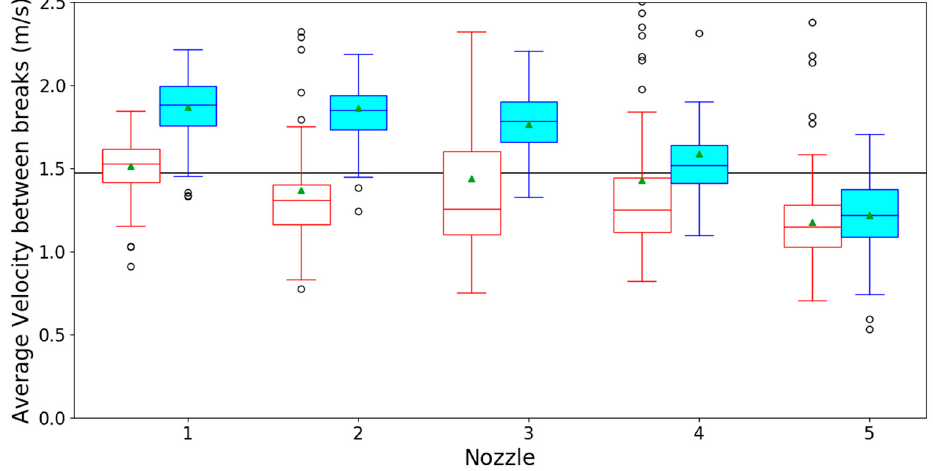
Figure A3. Boxplot graphs of the average liquid velocities in the experiments done with 9 L · min − 1 for the regular (red boxes) and vortex (blue boxes) showerhead and nozzles 1 (outermost) to 5 (innermost). The green triangles are the calculated population mean. The horizontal black line is the expected liquid velocity calculated using continuity law [15] by taking the flow rate divided by the total nozzle surface area.